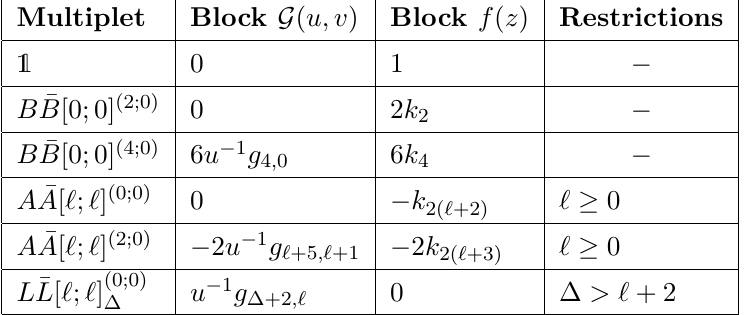
Table 4 . List of multiplets that appear in the M × M OPE, where M is the N = 2 moment map operator. The superconformal blocks can be expressed in terms of two functions G ( z, ¯ z ) and f ( z ) , as discussed around equation (2.25). In our conventions, the contribution from the lowest-dimension operator is always unit normalized.